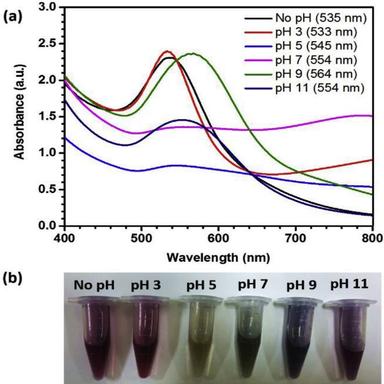
(a) UV–vis spectra of AuNPs synthesized using Lonicera japonica flower extract at various pH values (no pH adjustment, pH 3, 5. 7. 9, and 11) and (b) color changes after 2 min reaction incubation (from left to right: no pH adjustment, pH 3, 5. 7. 9, and 11). (For interpretation of the references to color in this figure legend, the reader is referred to the Web version of this article.)